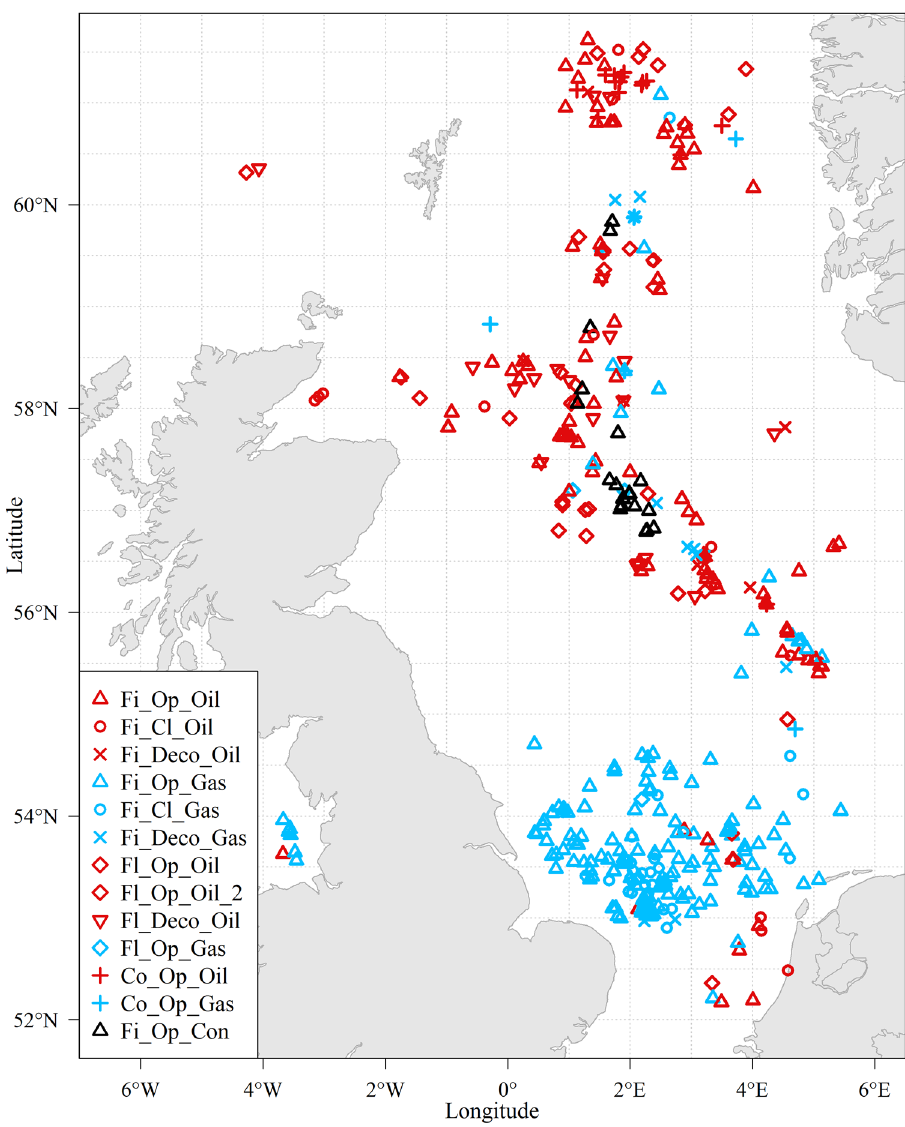
Figure 2. Map of oil and gas platforms in the North Sea. Symbols denote the cluster to which the platform was assigned during the clustering process, and are coloured by hydrocarbon product. The clusters are designated as structure type_status_product, with the abbreviations being used: Fi, Fl and Co for Fixed steel, Floating steel and Concrete gravity base; Op, Cl and Deco for Operational, Closed down and Decommissioned; and Oil, Gas and Con being Oil, Gas, and Condensate. The map was generated using the ‘maps’ and ‘mapdata’ packages in R (v4.1.2; https:// www.r- proje ct.